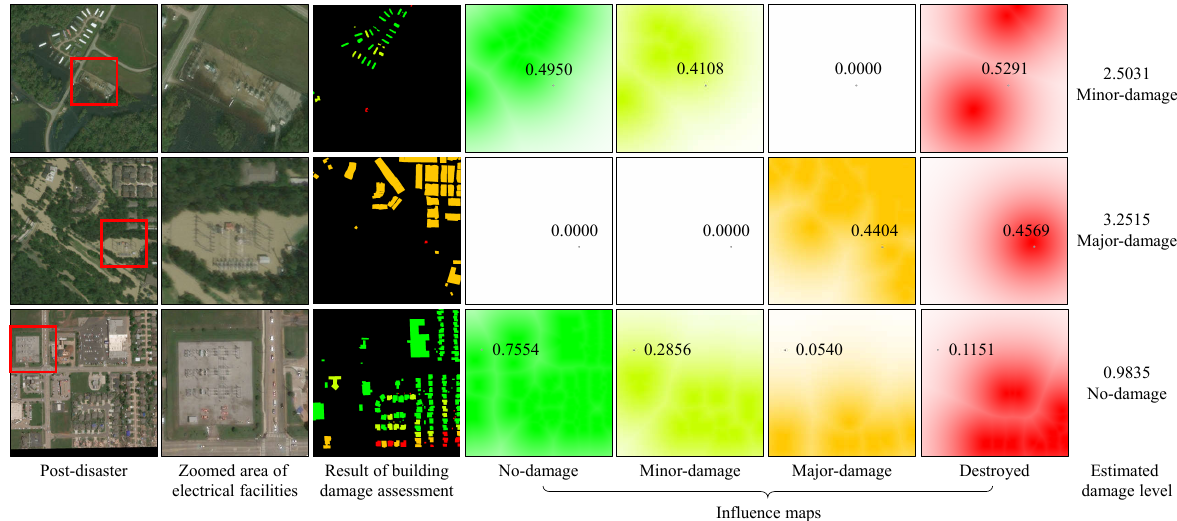
Figure 7. Qualitative evaluation for electrical facilities damage